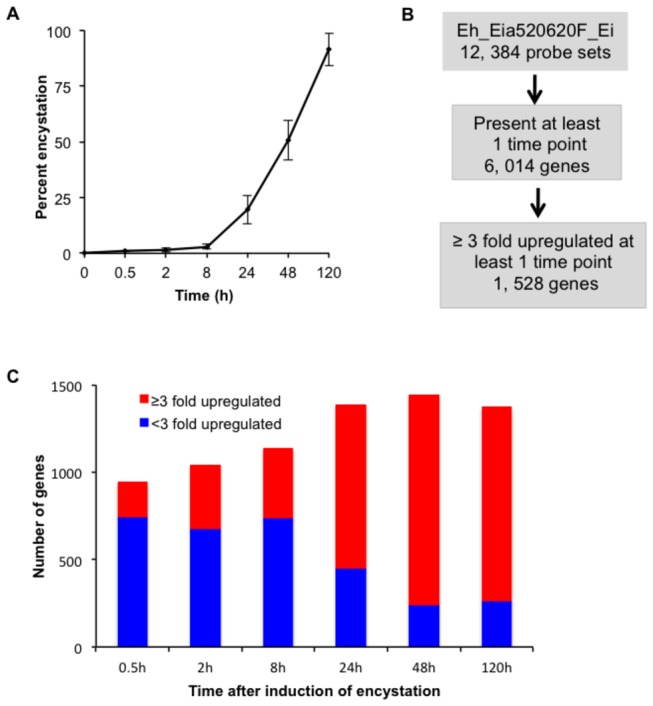
Overview of transcriptomic analysis.(A) Kinetics of differentiation. The percentages of the amoebae resistant to 0.05% sarkosyl during encystation are shown. Values are presented as % encystation and represent the mean ± S.D. of two independent experiments conducted in triplicate. (B) Flow of analysis. Microarray data were obtained in triplicates from

E

. invadens
 exposed to 47% LG medium for 0, 0.5, 2, 8, 24, 48, or 120 h, and genes expressed in at least one time point were selected for further analysis. The second data set of two biological replicates are shown as a representative. (C) The number of genes that were proven to be statistically significantly up-regulated by ≥3 or <3 fold at each time point of encystation.